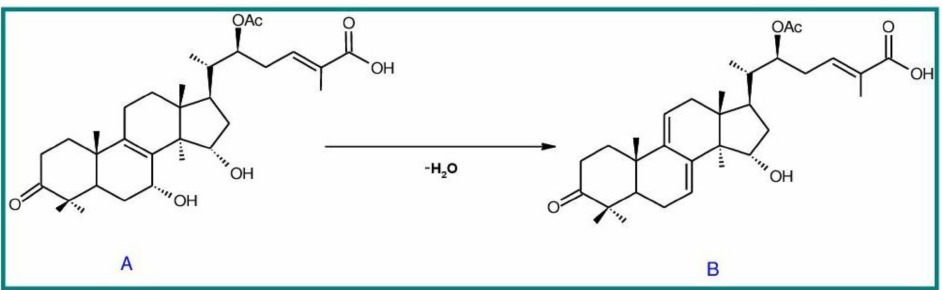
Figure 7. 7(8),9(11)-diene-triterpenoids: compound ( A ) was transformed to compound ( B ). Ganoderic acid Mf ( 263 ), ganoderic acid S ( 273 ) and ganoderic acid Mk ( 312 ) showed moderate cytotoxicity against 95D and HeLa human tumor cells [241,242], and their stability was studied with two pairs of double bonds at positions C-7(8) and 9(11) being observed